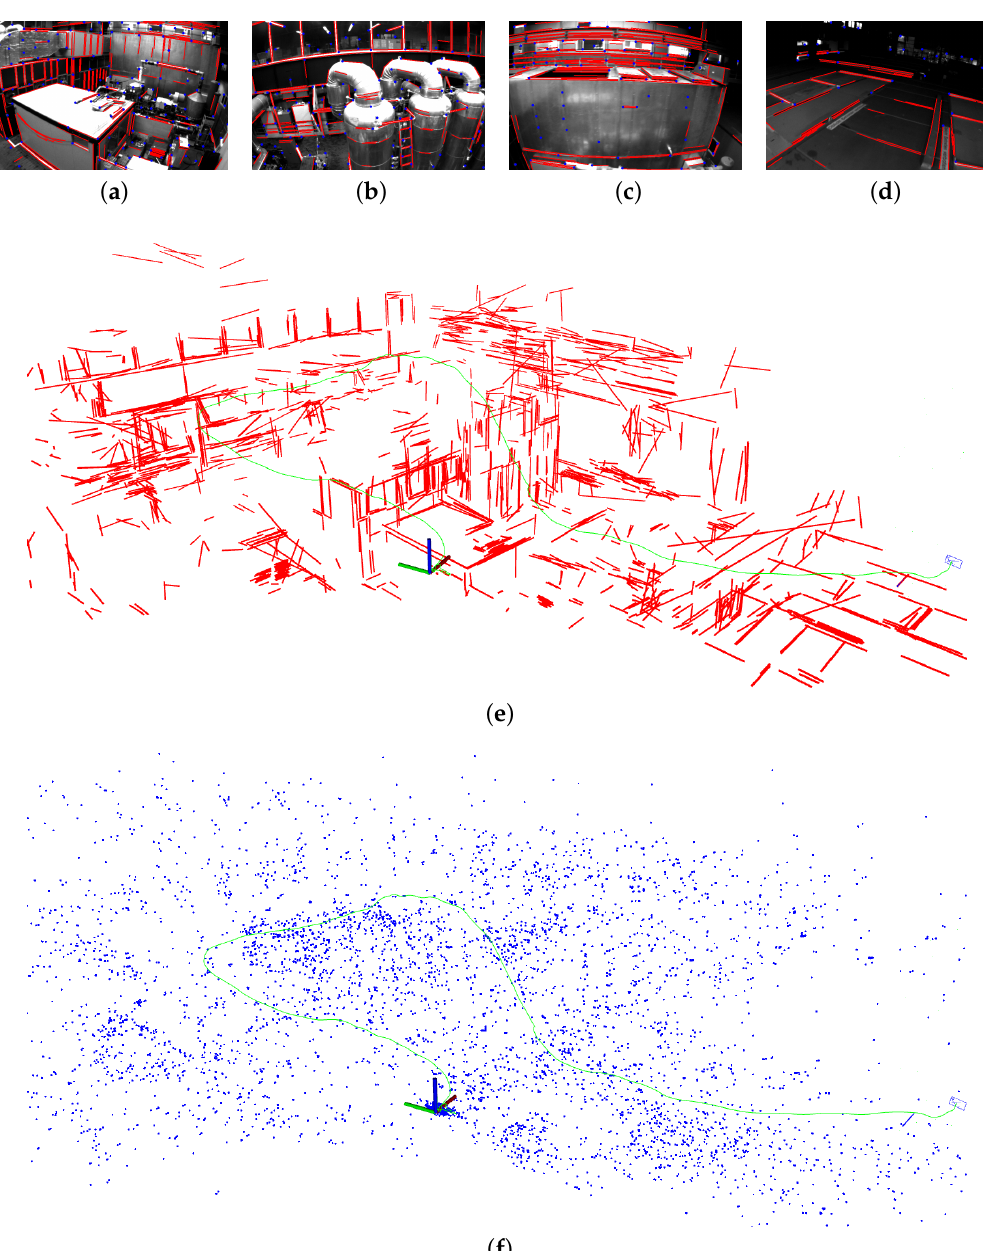
Figure 5. Mapping results in the MH_05_difficult sequence. ( a – d ) Detected point and line features for different frames. ( e ) The reconstructed line map (red) and the trajectory (green). The scenes with rich line features (such as the window, baluster, and cabinet) are clearly reconstructed from the map. ( f ) The reconstructed point map (blue). As compared to the line map, the structure is hard to identify in the point